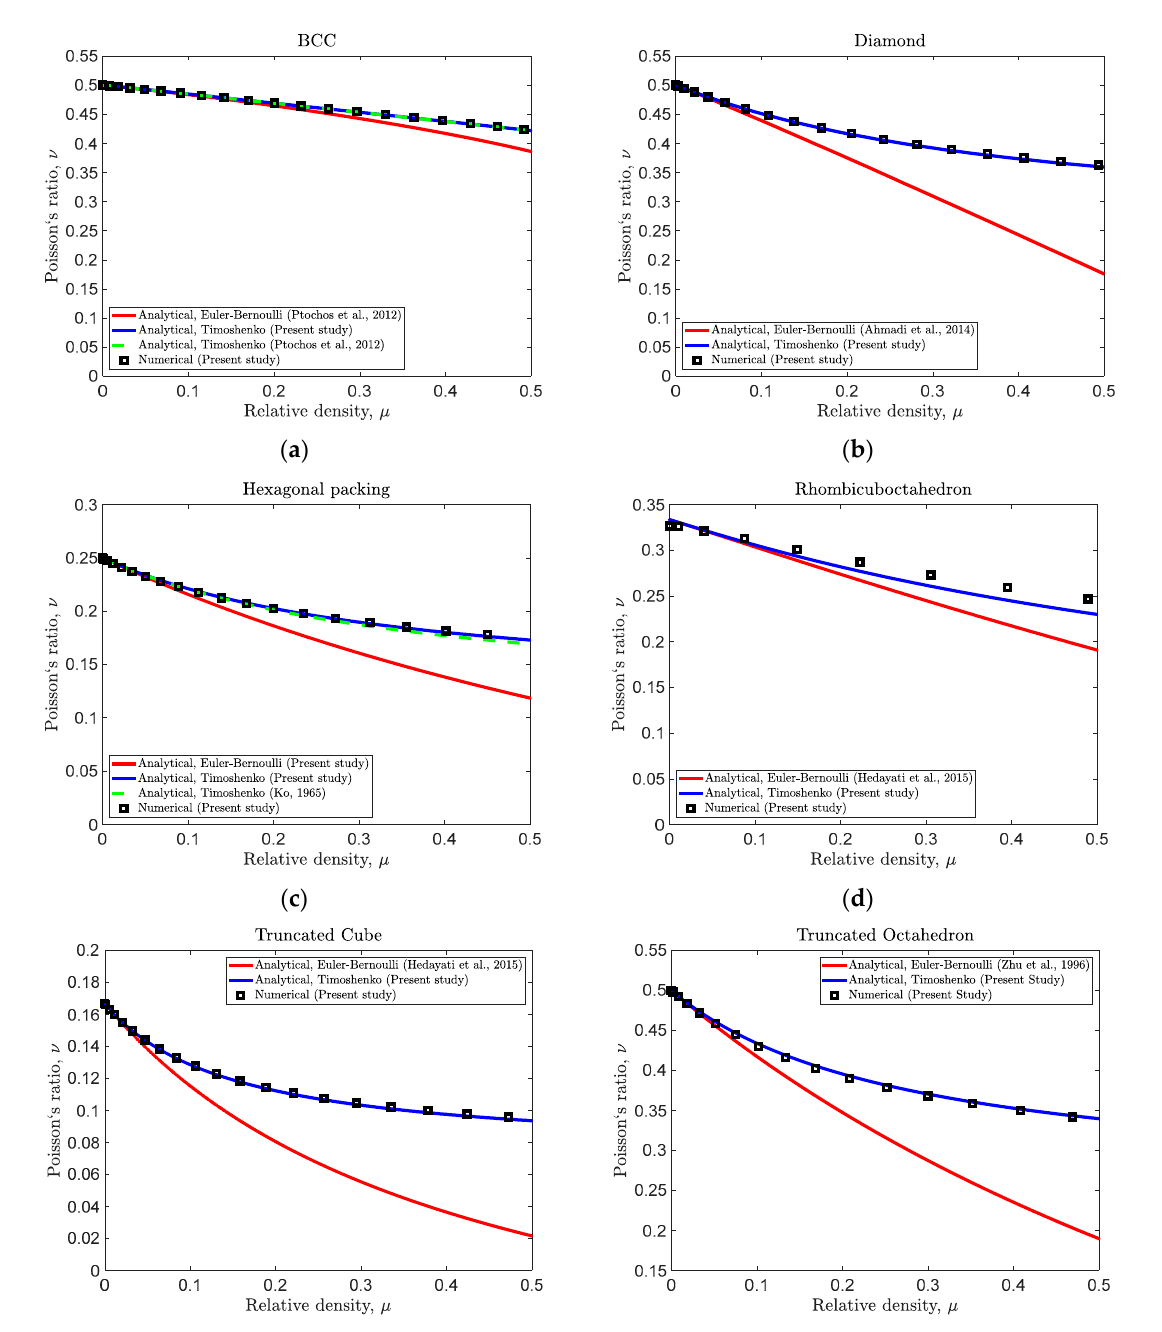
Figure 6. Comparison of analytical (Euler–Bernoulli and Timoshenko) and numerical values of normalized elastic modu- lus for different unit cell types: ( a ) BCC, ( b ) diamond, ( c ) hexagonal packing, ( d ) rhombicuboctahedron, ( e ) truncated cube, and ( f ) truncated octahedron.